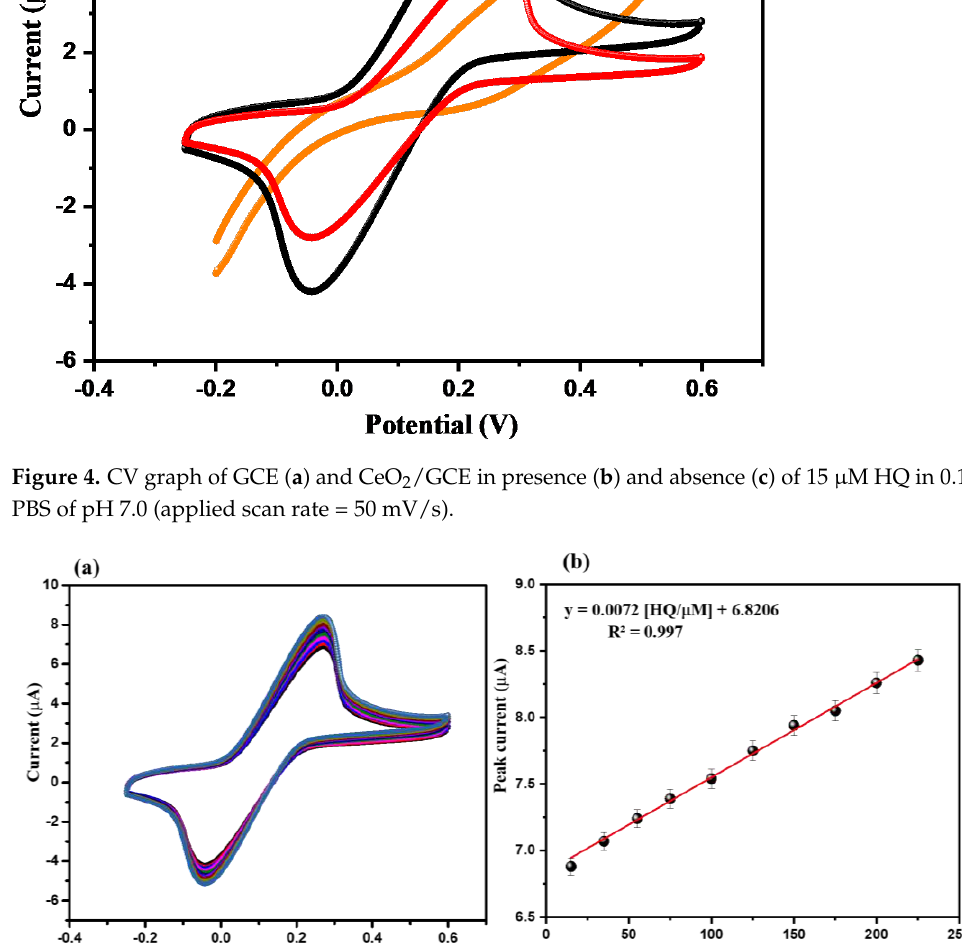
performance/ability of the CeO 2 /GCE was also checked using the CV technique. The CV graphs of the CeO 2 /GCE were obtained at a fixed concentration of 15 µM of HQ in 0.1 M PBS (pH = 7.0) at various applying scan rates (50 to 500 mV/s). The collected CV graphs of the CeO 2 /GCE in 15 µM of HQ in 0.1 M PBS at a pH of 7.0 are presented in Figure 6a. The CV results indicated that the current response for CeO 2 /GCE increases when applying scan rate changes from 50 mV/s to 500 mV/s (Figure 6a). The calibration curve between current responses and the square root of the applied scan rates was plotted, which is displayed in Figure 6b. The calibration plot between the current response and square root of the scan rate suggested that the current response increases linearly with an increasing applied scan rate, where R 2 = 0.99 (Figure 6b). Figure 6. CVs ( a ) of CeO 2 /GCE in presence of 15 µM HQ in 0.1 M PBS (pH = 7.0) at different applied scan rates (50, 100, 150, 200, 250, 300, 350, 400, 450, and 500 mV/s). Calibration curve of peak current versus scan rate ( b ). According to the recently published literature, it has been observed that differential pulse voltammetry (DPV) is a highly sensitive and efficient electrochemical sensing technique compared to the CV or linear sweep voltammetry. Thus, we have also applied the DPV technique to detect the HQ using CeO 2 /GCE as the electrochemical sensor. The DPV graph of the CeO 2 /GCE and bare GCE were obtained in the presence of 15 µM of